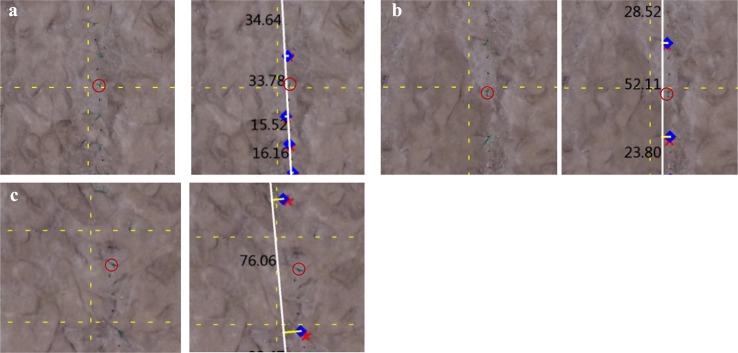
UAV Image at Sicm_5m.The letter i indicates different distances of maize interval. (a) S18cm_5m, (b) S27cm_5m, and (c) S36cm_5m.